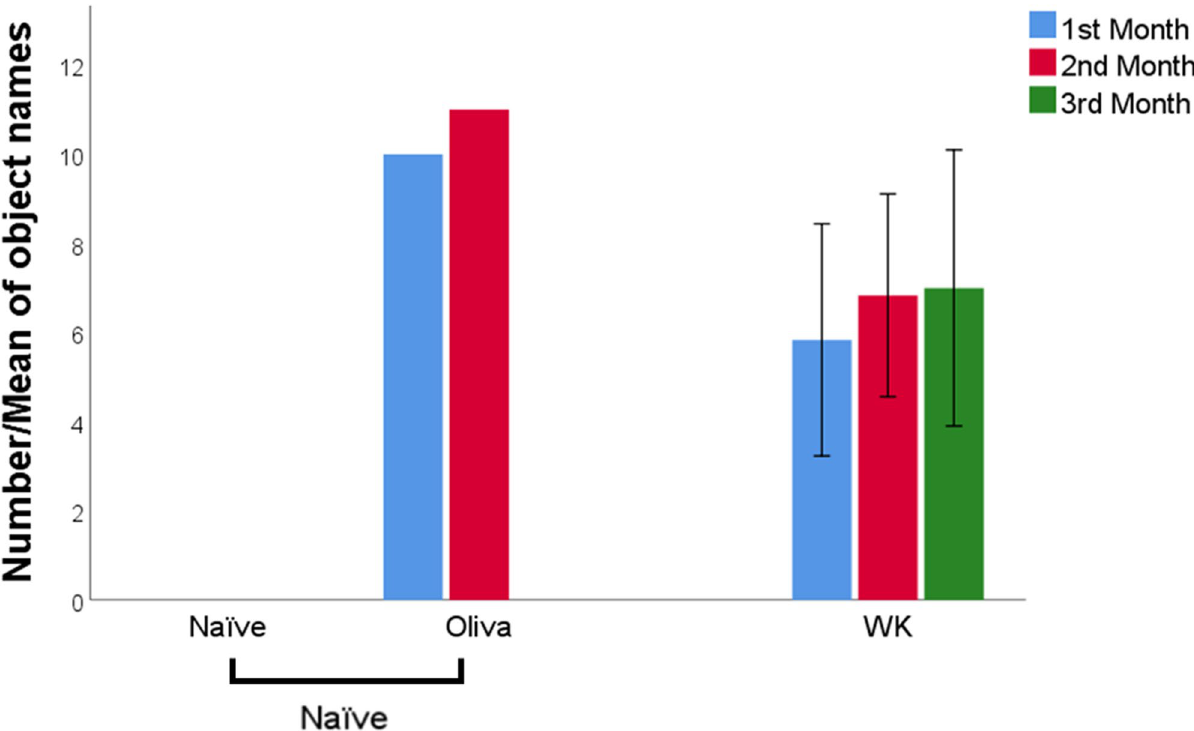
Figure 2. The bars show the number (for Oliva) or the mean ± SE (for all other subjects) of toys learned each month by the two dogs’ groups (naïve and WK) and by the outlier Oliva, the only naïve dog that learned new toy names over the course of the